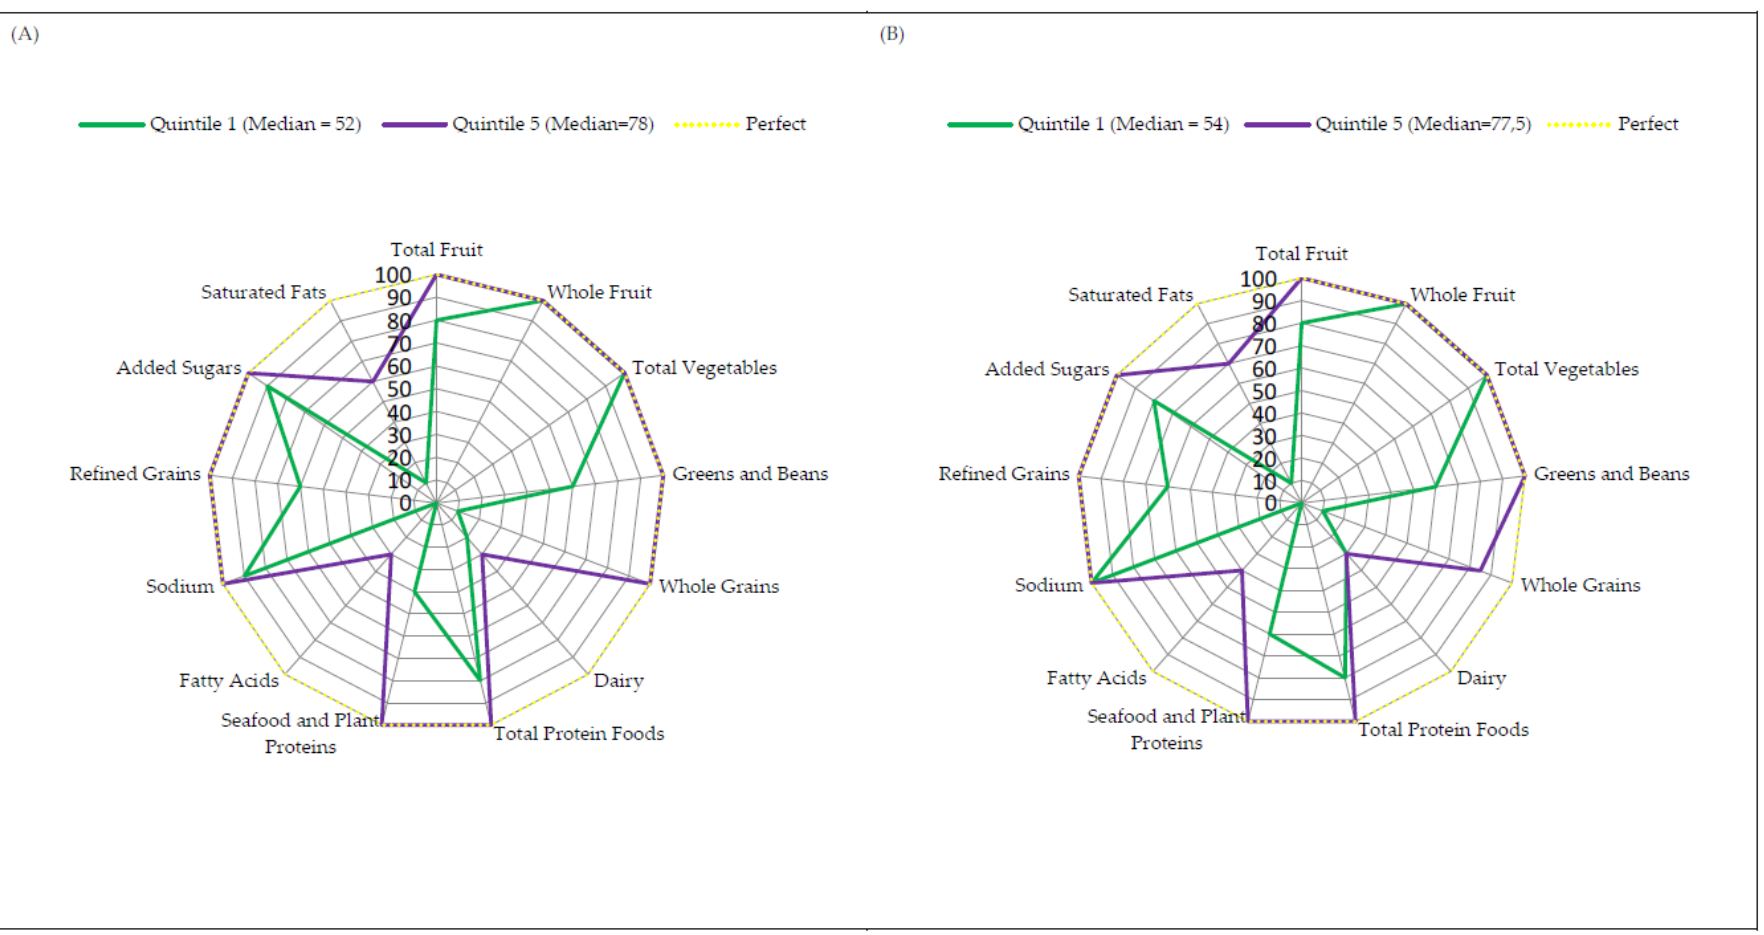
Figure 2. Radar graphs depicting a perfect score (100 points) and median component scores for ( A ) study group and ( B ) control group score in quintile one and quintile five for HEI-2015.